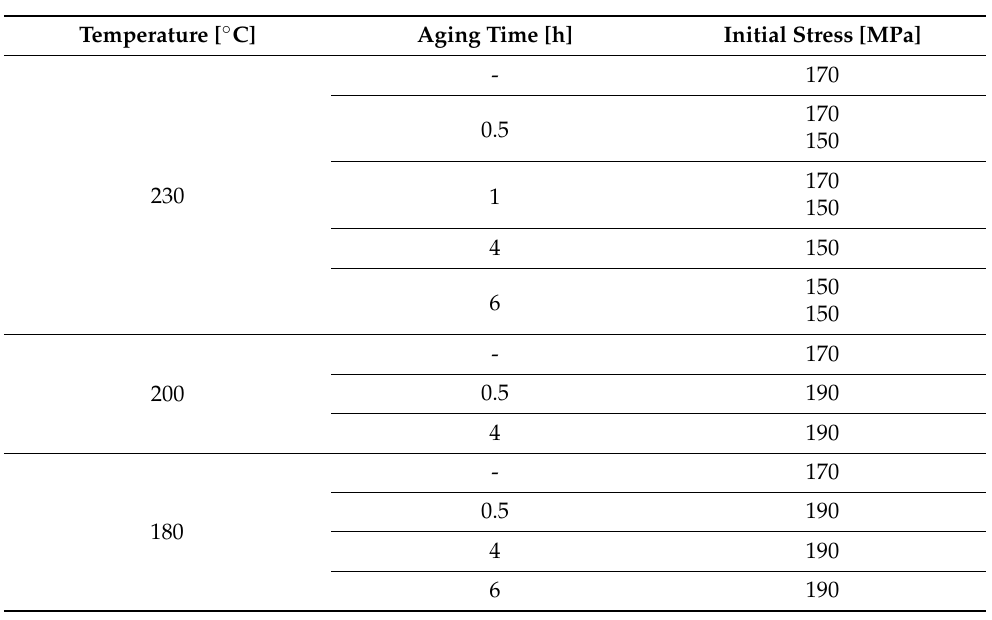
Table 1. Measured chemical composition of the AlSi 7 Cu 0.5 Mg. Element Si Fe Cu Mg Ti Al wt.% Table 2. List of experimental conditions for the relaxation tests. Temperature [ ◦ C] Aging Time [h] Initial Stress [MPa]